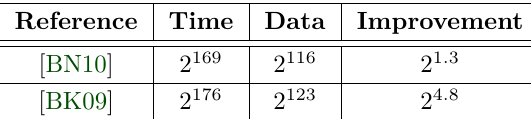
Figure 11: Recovery of other subkey bytes in the boomerang attack against 10-round AES -256 Table 2: Summary of existing attacks against full-round AES -192 and the corresponding improve- ments with the help of 2-round boomerang